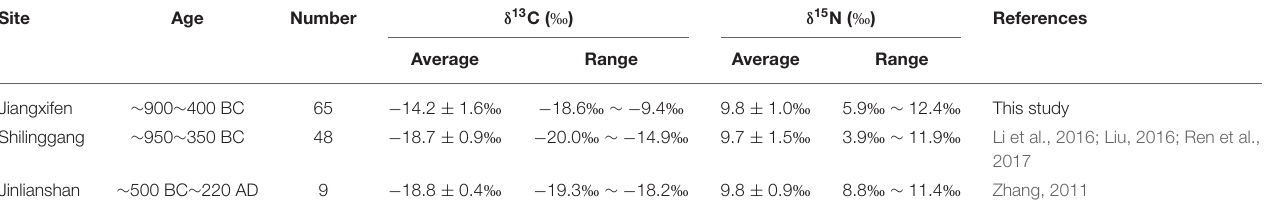
TABLE 4 | Comparison of results of the human bone collagen isotope from archaeological sites in Yunnan.